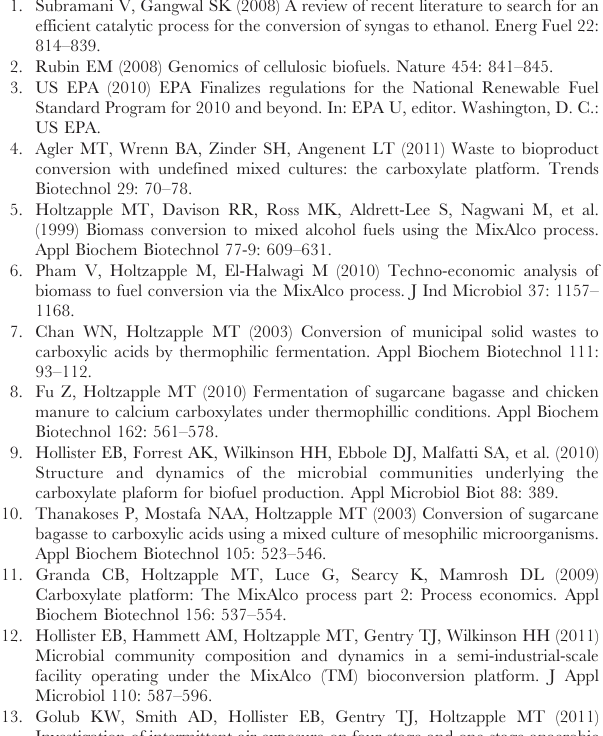
Figure S1 Protein recruitment plots of the thermophilic metagenome versus high-coverage isolate genomes. The length of each genome is depicted along the x -axis. BLAST hits with . 30% identity are indicated by blue, hits with . 60% identity are indicated by green, and hits with . 90% identity are indicated by red. Figure S2 Protein recruitment plots of the mesophilic metagenome versus high-coverage isolate genomes. The length of each genome is depicted along the x -axis. BLAST hits with . 30% identity are indicated by blue, hits with . 60% identity are indicated by green, and hits with . 90% identity are indicated by red. Table S1 Fermentor performance metrics following 16 days ’ incubation. Table S2 Proportion of protein coding genes (%) re- ceiving a functional annotation within each of the databases listed.